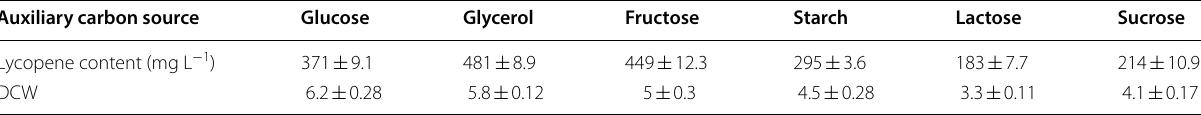
YT medium) on the lycopene yield of the strain EBI ×